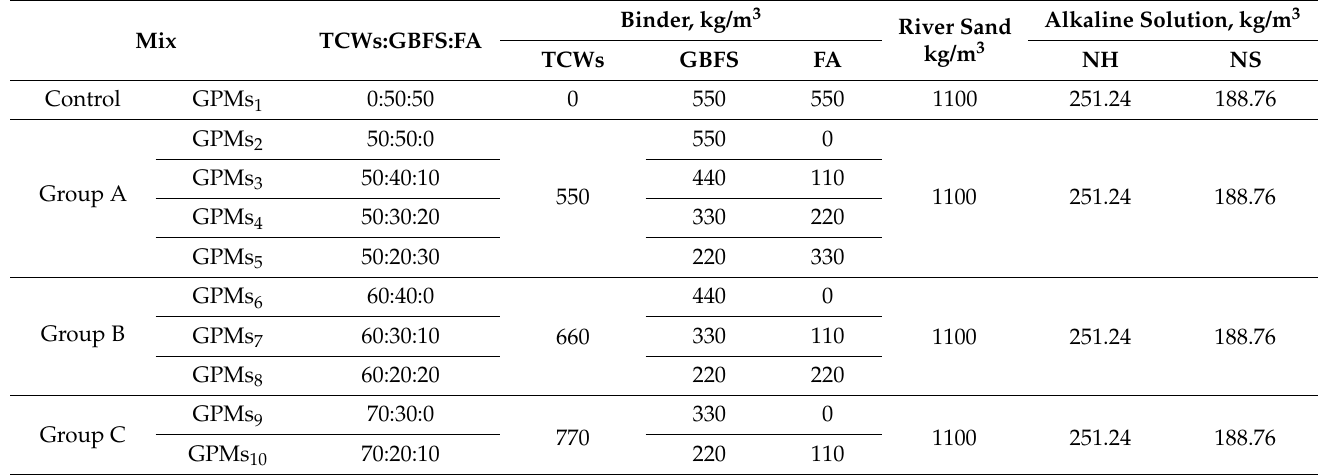
Table 2. High volume TCWs geopolymer mix